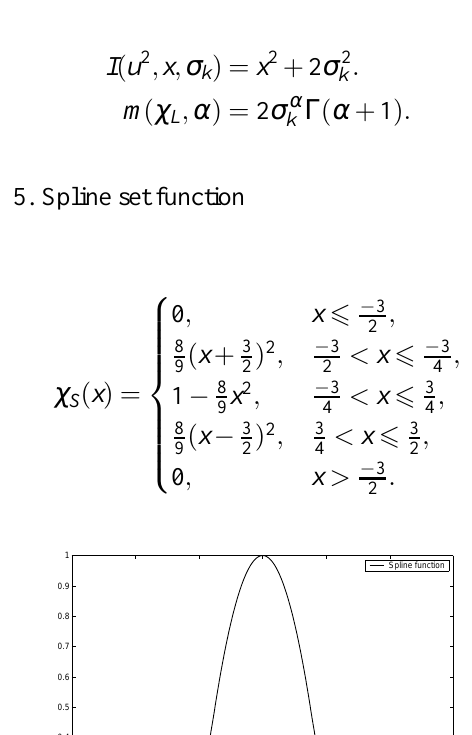
Fig. 3. Parabol set function.